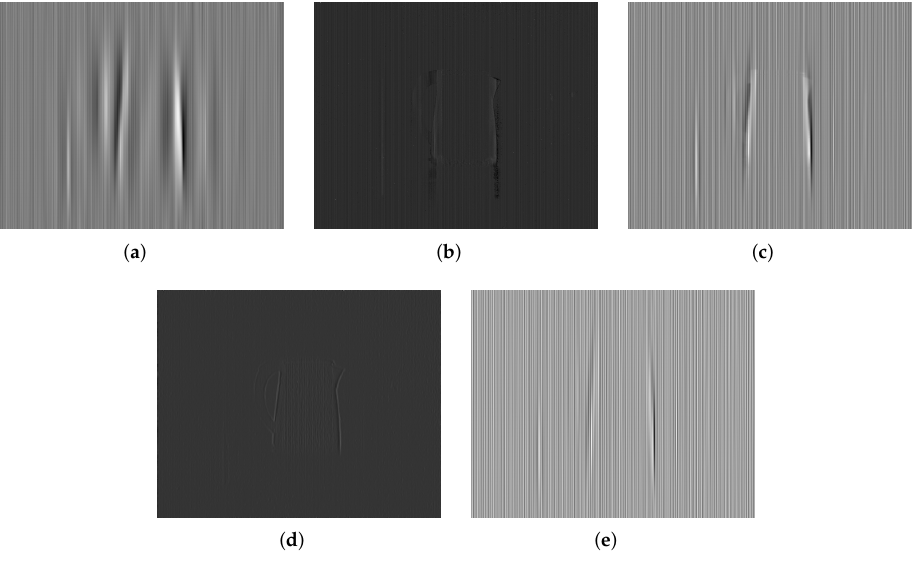
Figure 12. NUN results for Kettle. ( a ) WTSF; ( b ) MIRE; ( c ) GIF; ( d ) CNN; ( e )